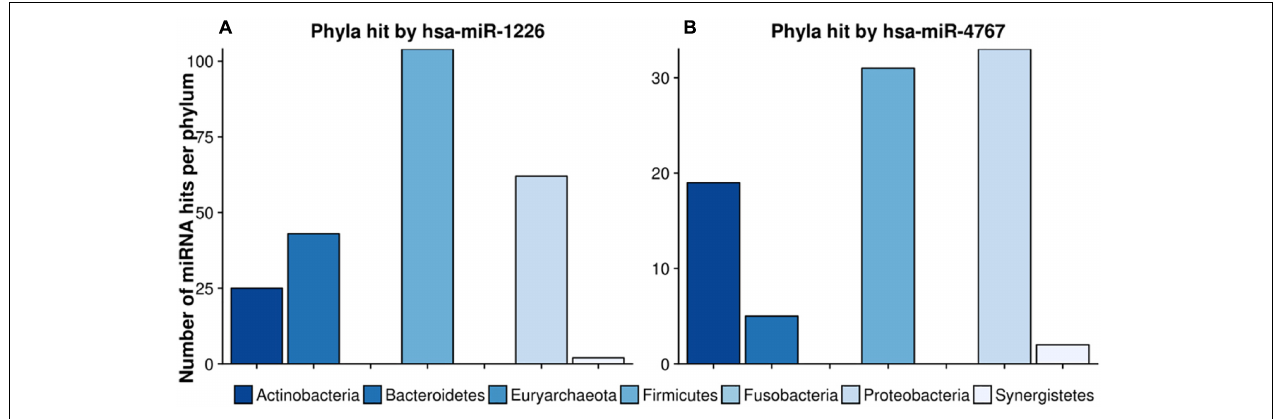
FIGURE 8 | Number of hits per phylum from miRNAs with the largest target matching. In (A) , the hit counts of hsa-miR-1226 per phylum are given, in (B) the number of targeted regions of hsa-miR-4767 counted for different phyla. The legend can be found at the bottom. The colors refer to different